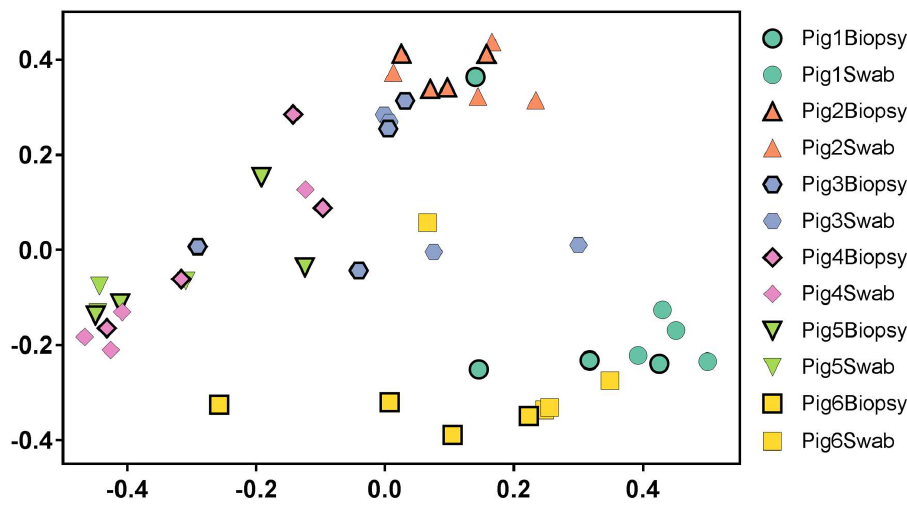
Fig 3. Comparison of bacterial community structure in pig biopsy and swab samples. PCoA based on theta YC distances.Biopsy samples are shown with thicker borders while swabs are shown with thinner